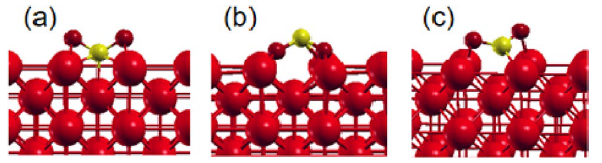
2 adsorption in ( a ) C 2v mode ( b )